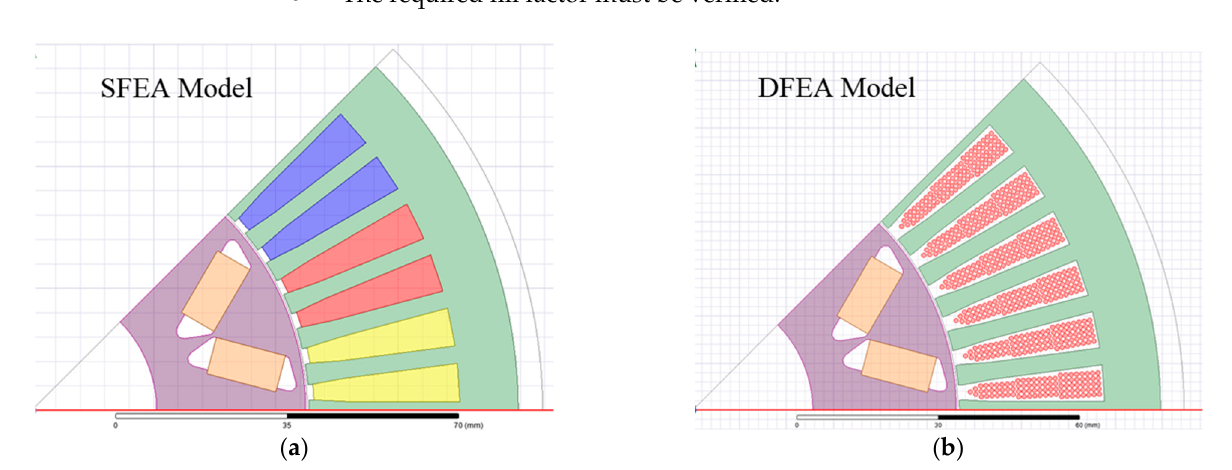
Figure 4. Geometry of the machine used for ( a ) SFEA model and ( b ) DFEA model. The studied strand’s diameter ranges from 0.6 mm to 1 mm. Only manufactured values of strand diameter in this range are investigated. The studied n.s.h. ranges from 1 to 100. All values of n.s.h. and strand diameter are checked, and only feasible winding configurations that satisfy the three conditions above are selected. These three conditions allow realistic windings similar to those used in real electrical machines [39]. For each winding configuration (n.s.h. and strand’s diameter), the location of each strand is known thanks to its virtual location. The closest grid’s node to the center of each virtual strand is determined, as shown in Figure 5.